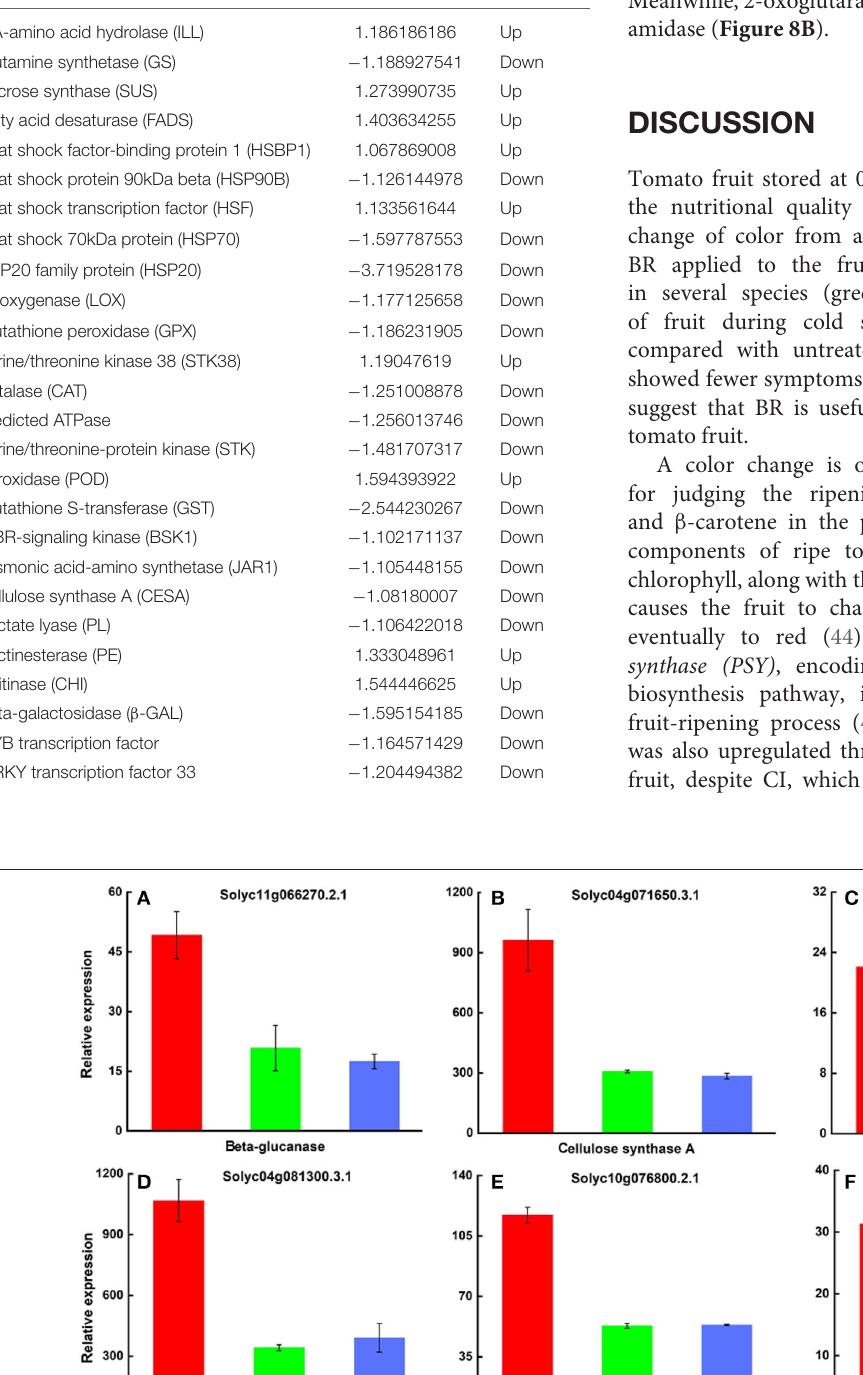
Frontiers in Nutrition |